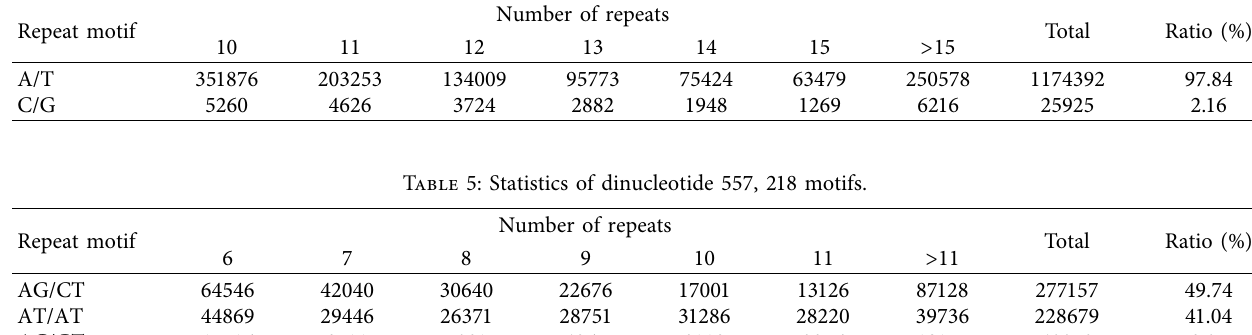
Table 4: Statistics of mononucleotide 1, 200, 317 motifs.